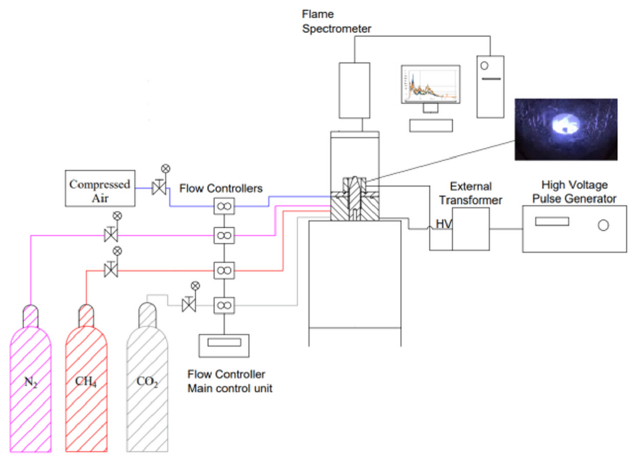
Figure 11. Scheme of the experimental setup.